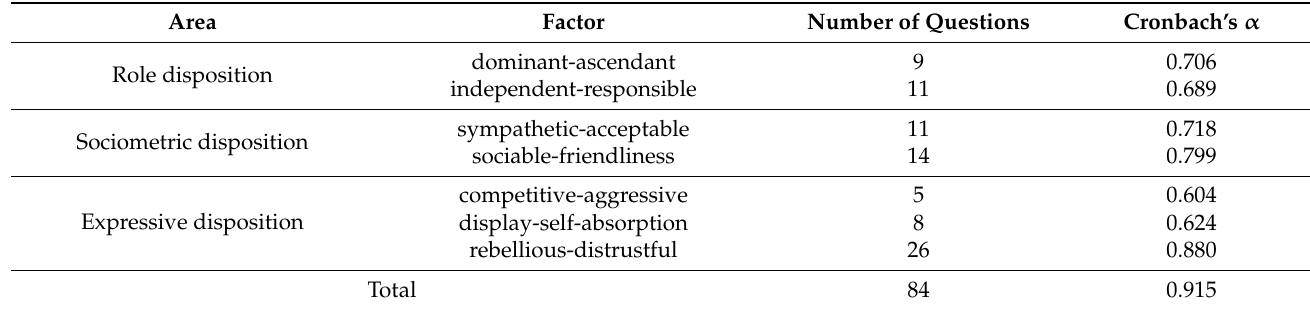
Table 5. Reliability of the personal relationship test.